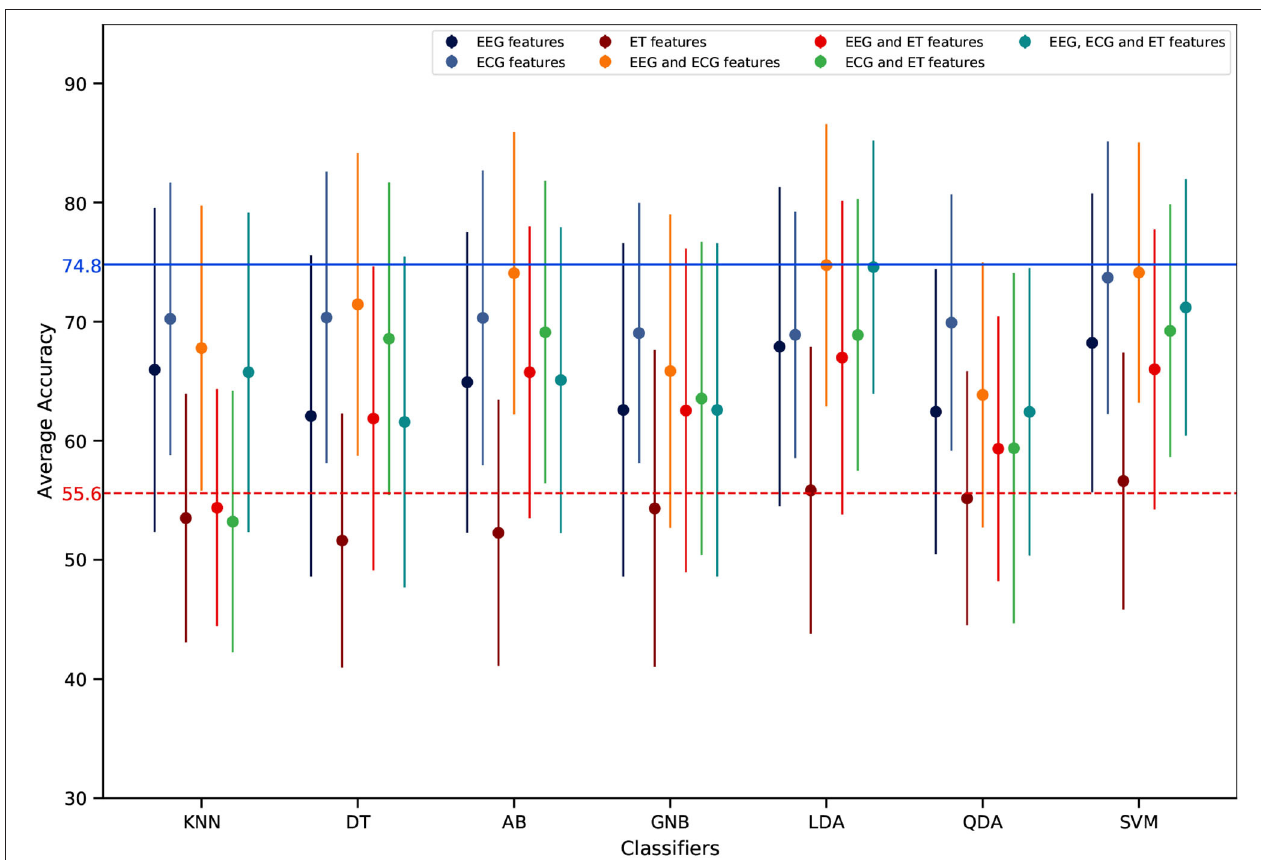
FIGURE 11 | Intra-subject mental workload estimation results per features and classifiers with the traditional validation design (average across participants). The dots represent the average score of each feature combination and the vertical line represents the associated standard deviation. The dashed horizontal red line represents the adjusted chance level while the blue one represents the highest classification